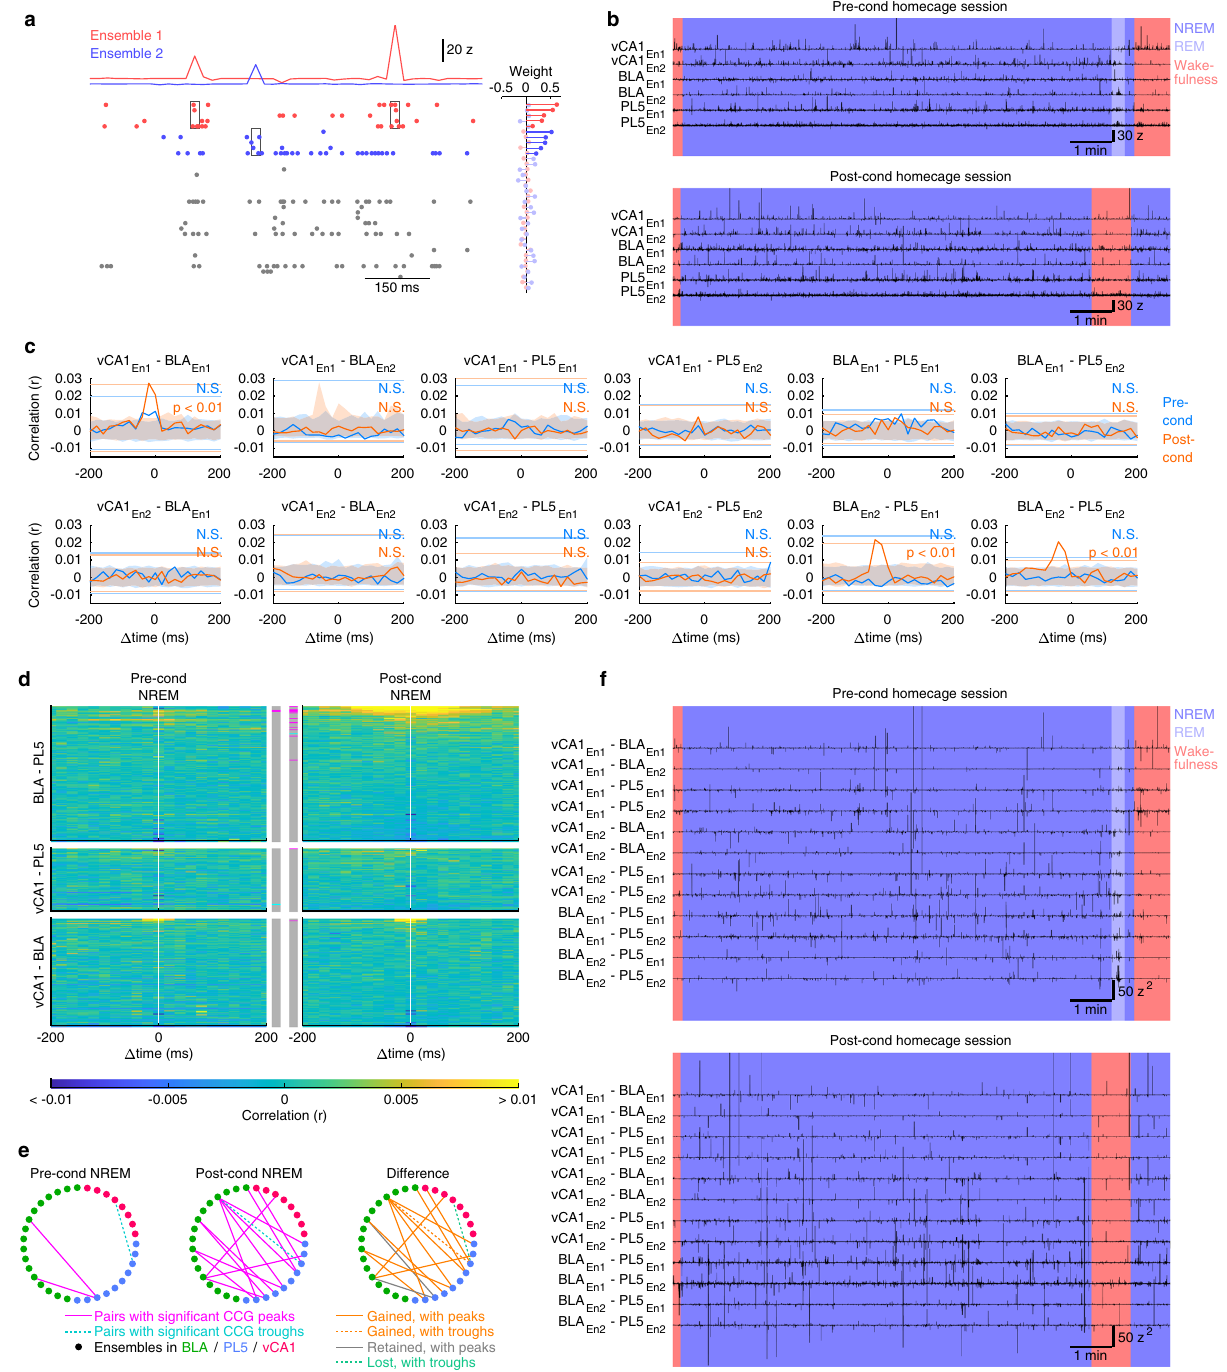
Pairs with significant CCG peaks Pairs with significant CCG troughs